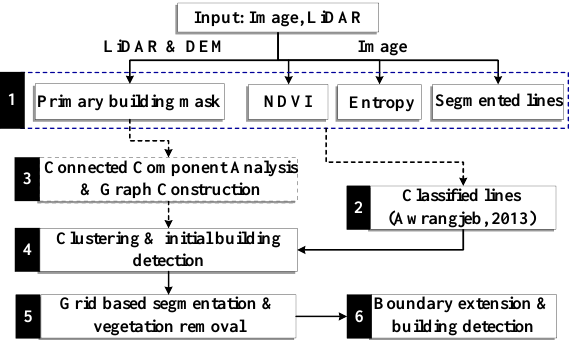
Figure 1. Work flow of proposed building detection technique